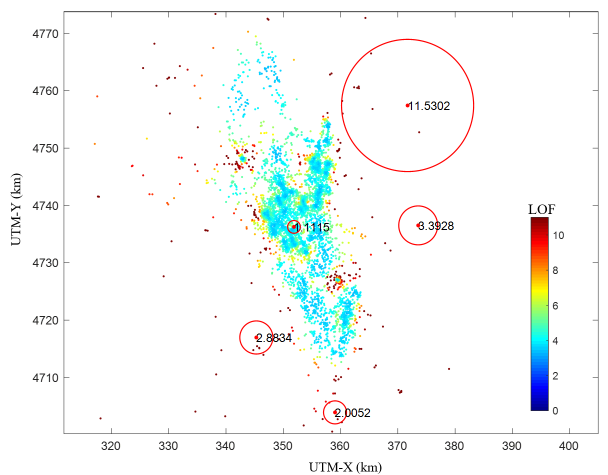
Figure 3. An example of LOF scores for 2-D points. Each point is colored by its LOF score. The radius of red circles on five selected points is in direct proportion to their LOF score (plotted in the cen- ter). It is observed that the central points with high density have low LOF scores, while the surrounding points have high